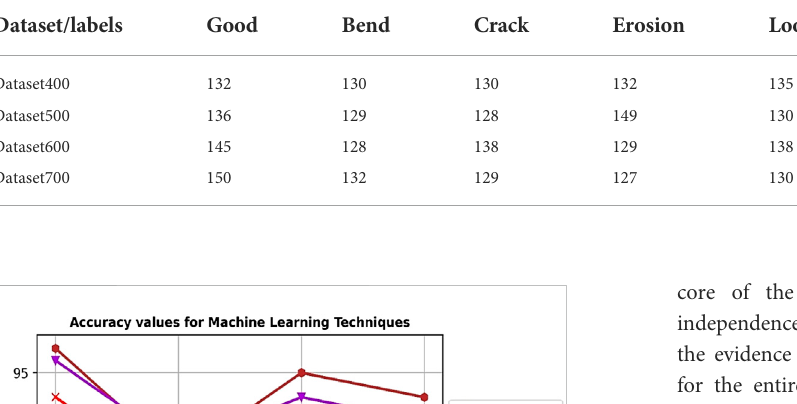
TABLE 4 The statistical information of the datasets.